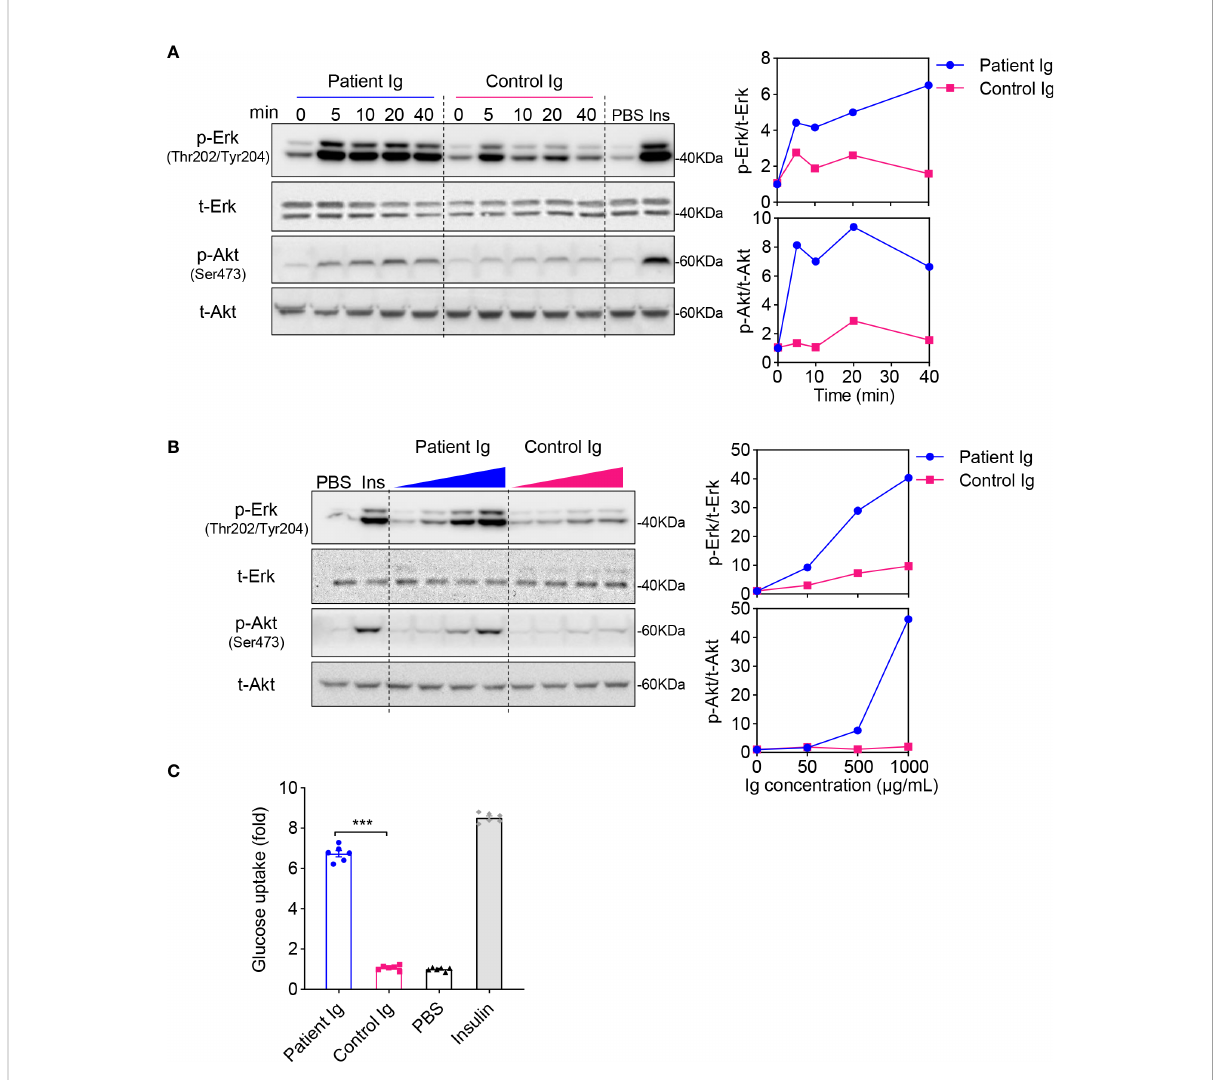
FIGURE 3 Immunoglobulins extracted from patient plasma exert insulin-like effects in CHO-hIR cells. (A, B) Con fl uent CHO-hIR cells were fasted for 4h, followed with treatment of 500 m g/mL immunoglobulins (Ig) for 0, 5, 10, 20, and 40 min (A) or treatment of 0, 50, 500, and 1000 m g/mL Ig for 15 min (B) . Treatment of PBS or 100 nM insulin was included as negative or positive control. p-Erk(Thr202/Tyr204), t-Erk, p-Akt(Ser473) and t- Akt were measured by immunoblotting. The relative values of p-Erk/t-Erk and p-Akt/t-Akt were quanti fi ed in the groups of Patient Ig and Control Ig separately. Representative results from three independent experiments were shown. (C) Glucose uptake was measured in CHO-hIR cells treated with 500 m g/mL Patient Ig, 500 m g/mL Control Ig, PBS or 100 nM insulin for 30 min (n=6,